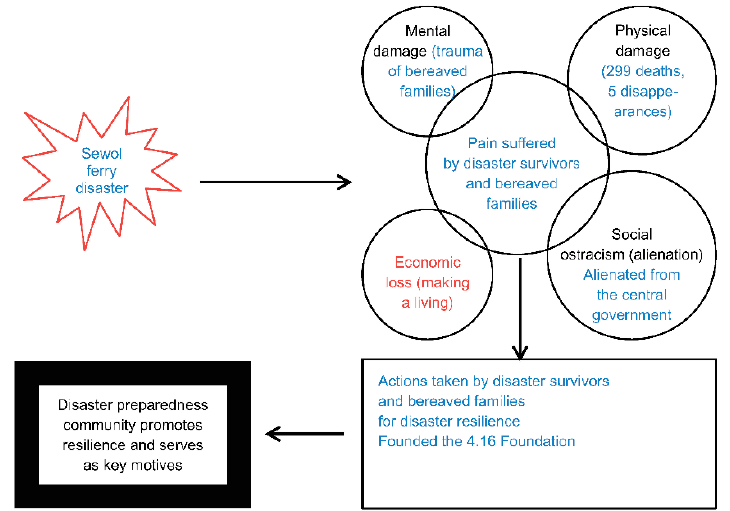
Figure 4. Disaster preparedness framework of disaster survivors and bereaved families for the Sewol Ferry disaster.